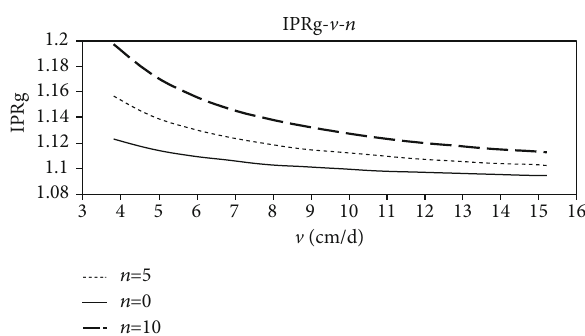
Figure 3: The relationship between gas IPR with the velocity of the combustion front at di ff erent time.